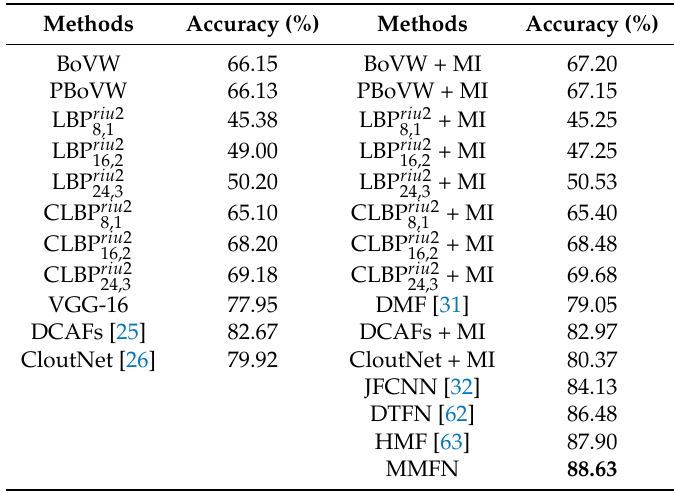
Table 2. The recognition accuracies (%) of the proposed MMFN and other methods.